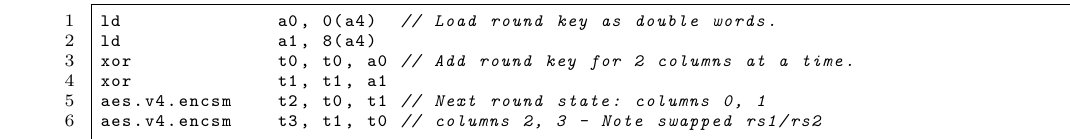
Figure 10: An AES encryption round implemented using V 4 .